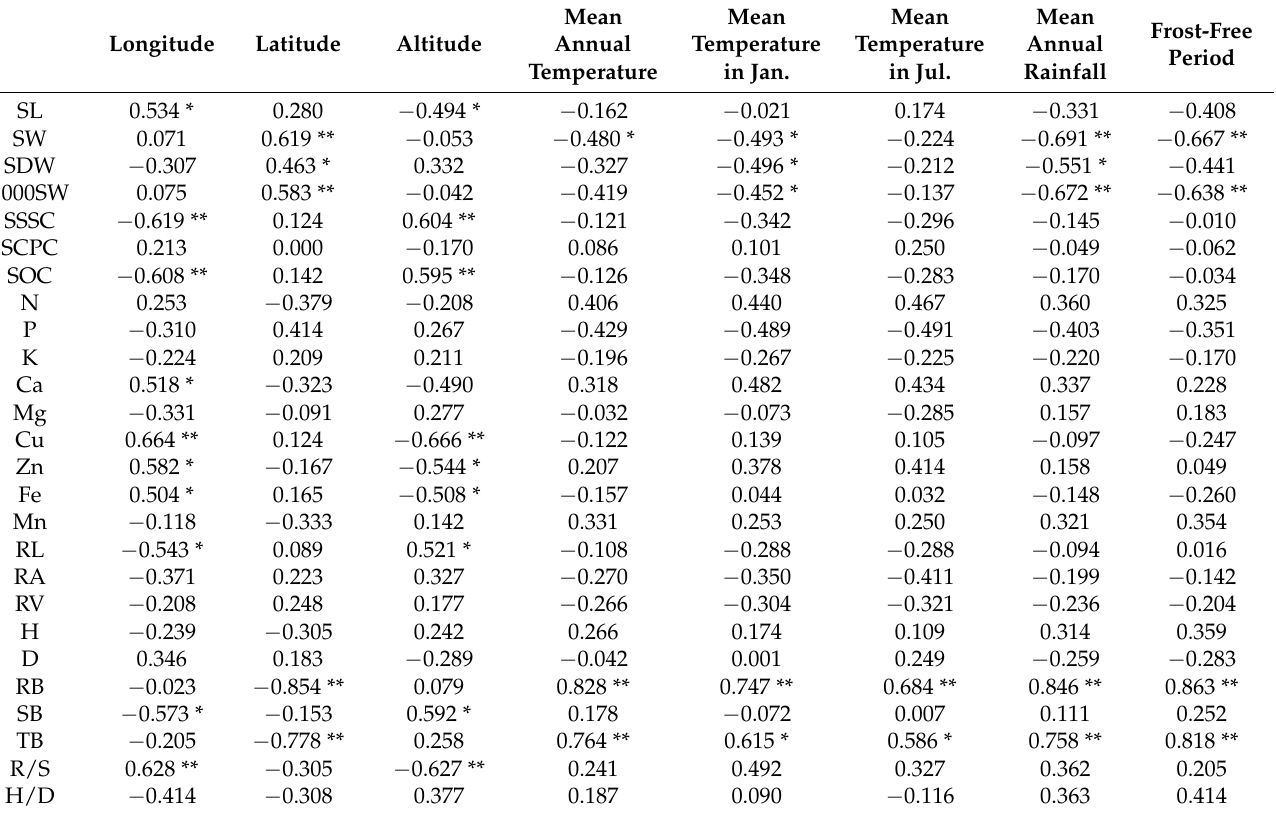
Table 14. Correlation coefficients between geographical factors, climatic factors, and seed/seedling parameters of four provenances of X. sorbifolium